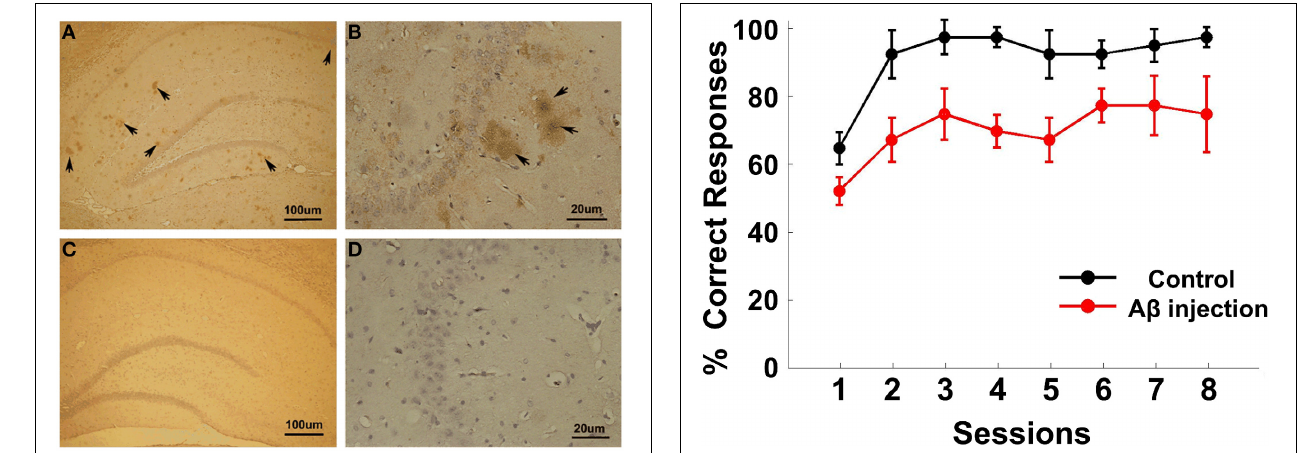
FIGURE 3 | Immunohistochemistry in A β 1 − 42 -induced toxicity model and control. (A,B) A β 1 − 42 -induced toxicity model. (C,D) Control group. Arrows showed A β 1 − 42 -positive immunostaining area of hippocampus. Amyloid plaques depositions in hippocampus of A β injection group were observed.